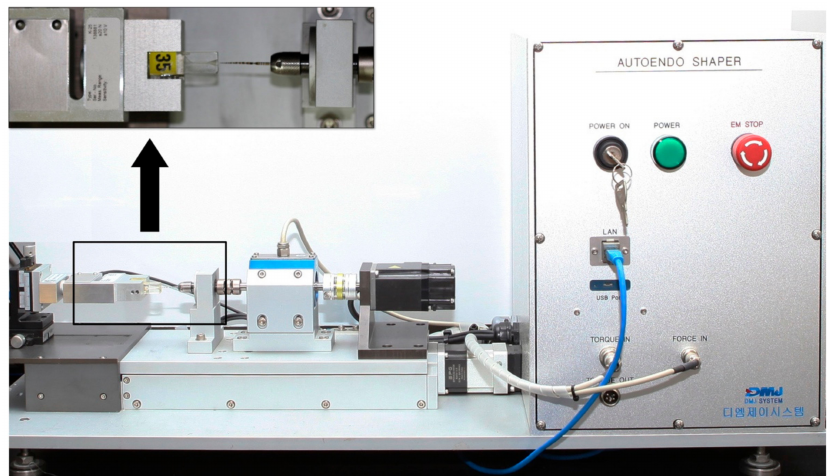
Figure 2. A custom-made test device (DMJ system, Busan, Korea). The simulated canal, force sensor, and engine-driven motor unit are shown in